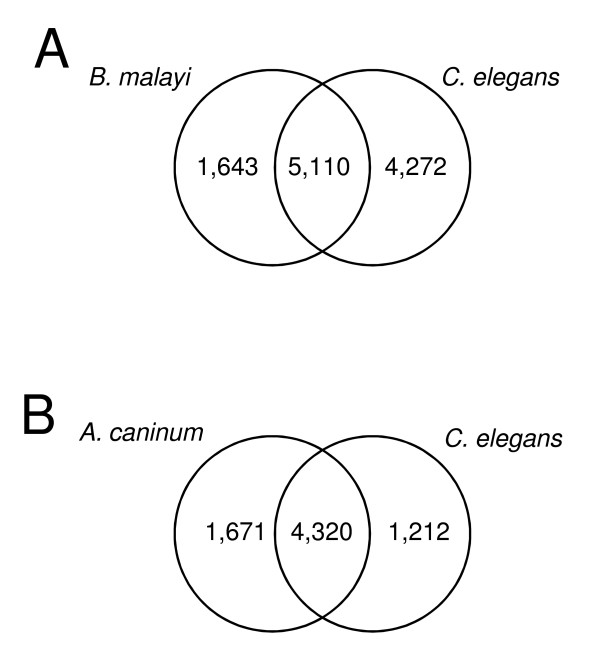
Venn diagram showing distribution of BLAST matches. Amino acid level homologies with bitscore of 50 or better were considered. (A) A. caninum transcripts homologous to B. malayi and C. elegans. Only 23% of the transcripts (11,025/48,326) shared homology, leaving 37,301 transcripts to be specific to A. caninum. (B) B. malayi genes homologous to A. caninum and C. elegans. About 62% of the 11,609 B. malayi genes shared homology. Higher number of B. malayi genes had homologs to the parasitic A. caninum compared to the free-living C. elegans, and 4,406 B. malayi genes did not share homology.